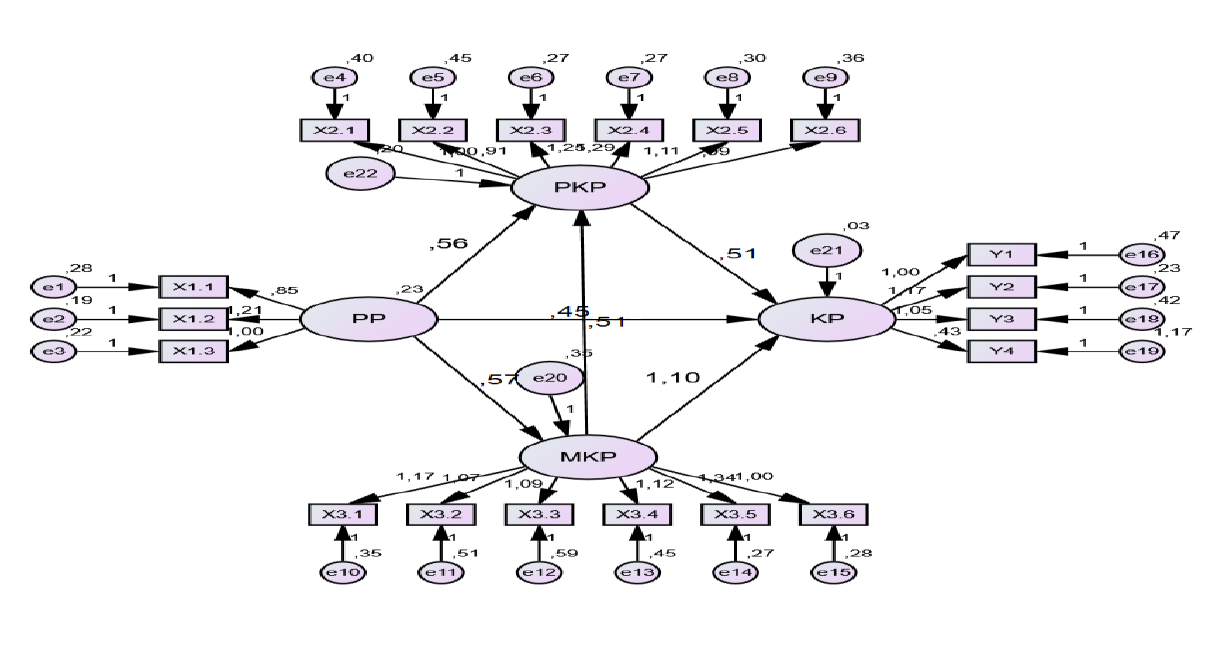
Fig. 1 : Outer Model of